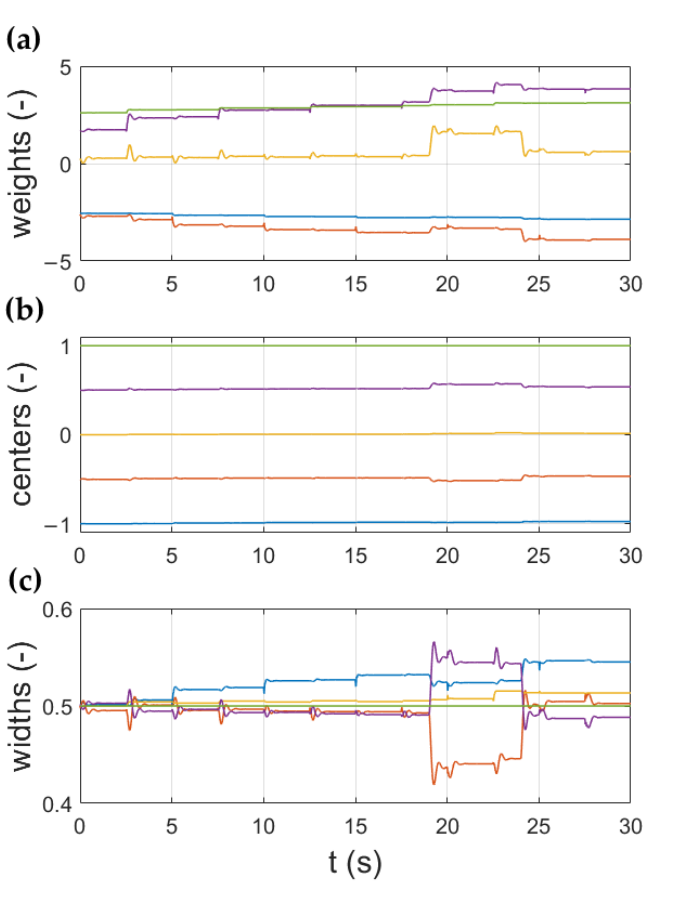
Figure 6. Change in the adaptive parameters of the RBF neural network: weights ( a ), centers ( b ), widths ( c ).